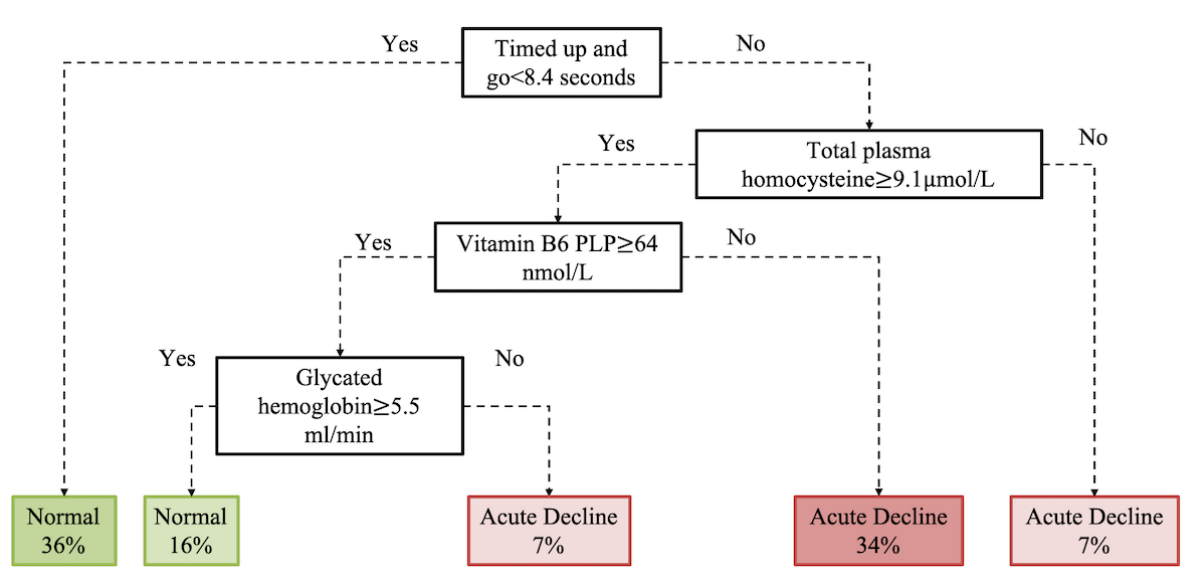
Figure 12. Decision tree classifier of rate of change of the Repeatable Battery for the Assessment of Neuropsychological Status score. PLP: vitamin B6 marker pyridoxal-5-phosphate.